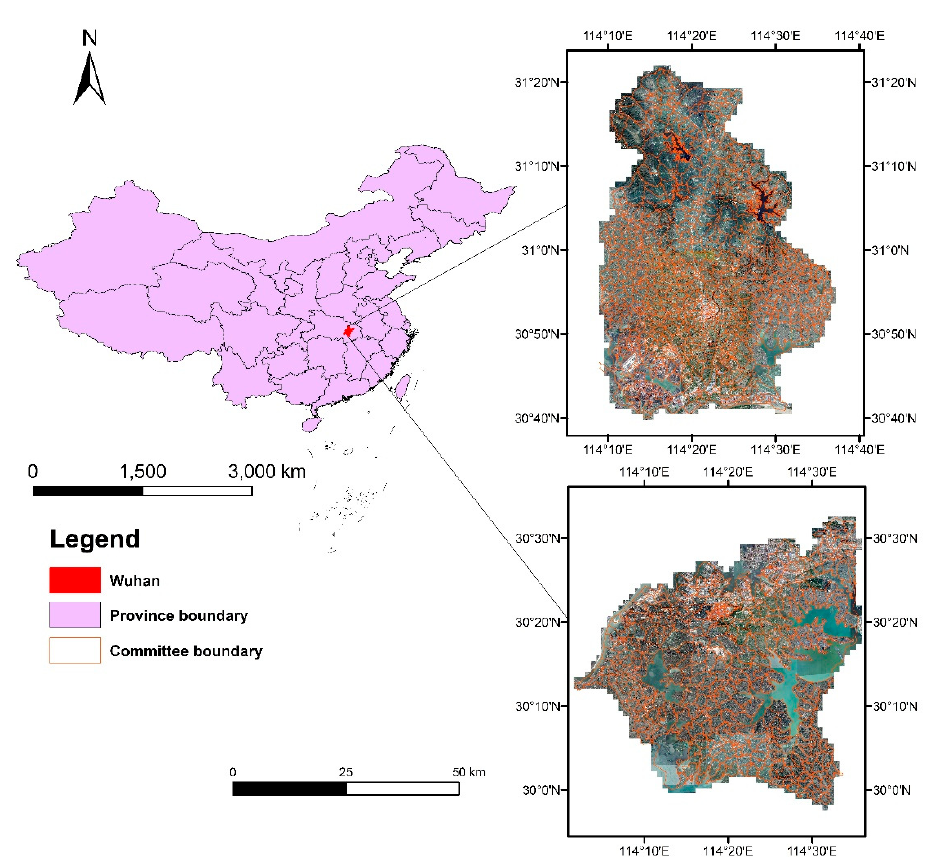
Figure 1. Study area map of Jiangxia and Huangpi with neighborhood and village Figure 1 . Study area map of Jiangxia and Huangpi with neighborhood and village boundaries.